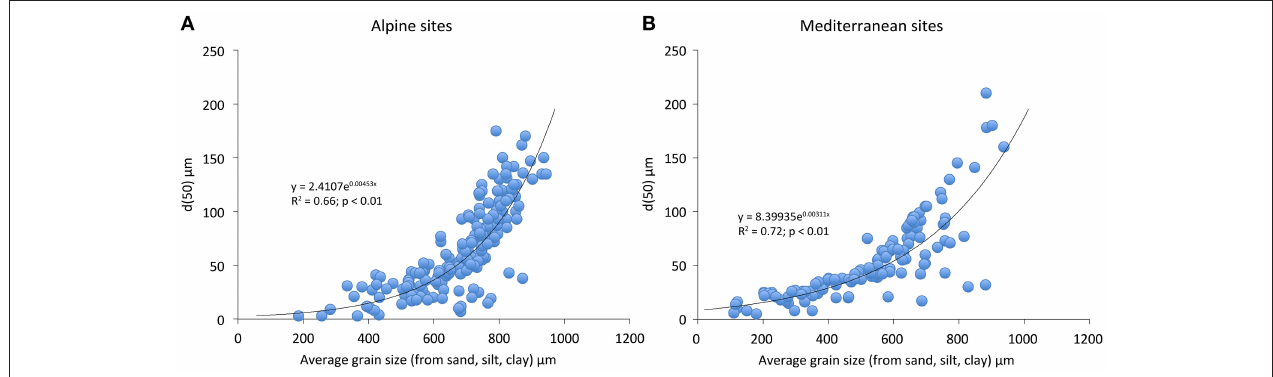
FIGURE 4 | Transfer functions to calculate d 50 for sites having only indications about the three fundamental grain size classes (sand, silt, clay) based on detailed grain size data for (A) the alpine ( Supplementary Table S3 ) and (B) Mediterranean type of sites ( Supplementary Table S4 ).